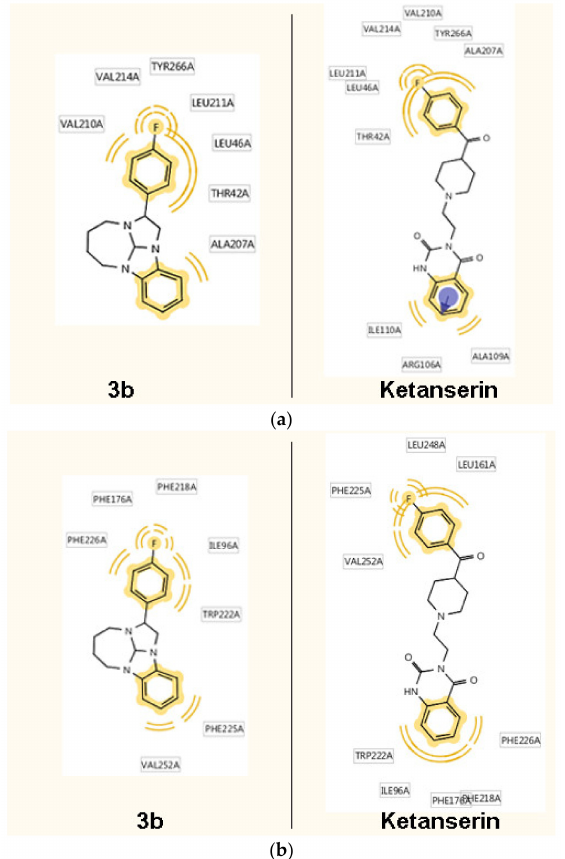
Figure 7. The nature of the binding of compounds at the sites of the 5-HT 2A receptor; ( a ) specific site; ( b ) allosteric